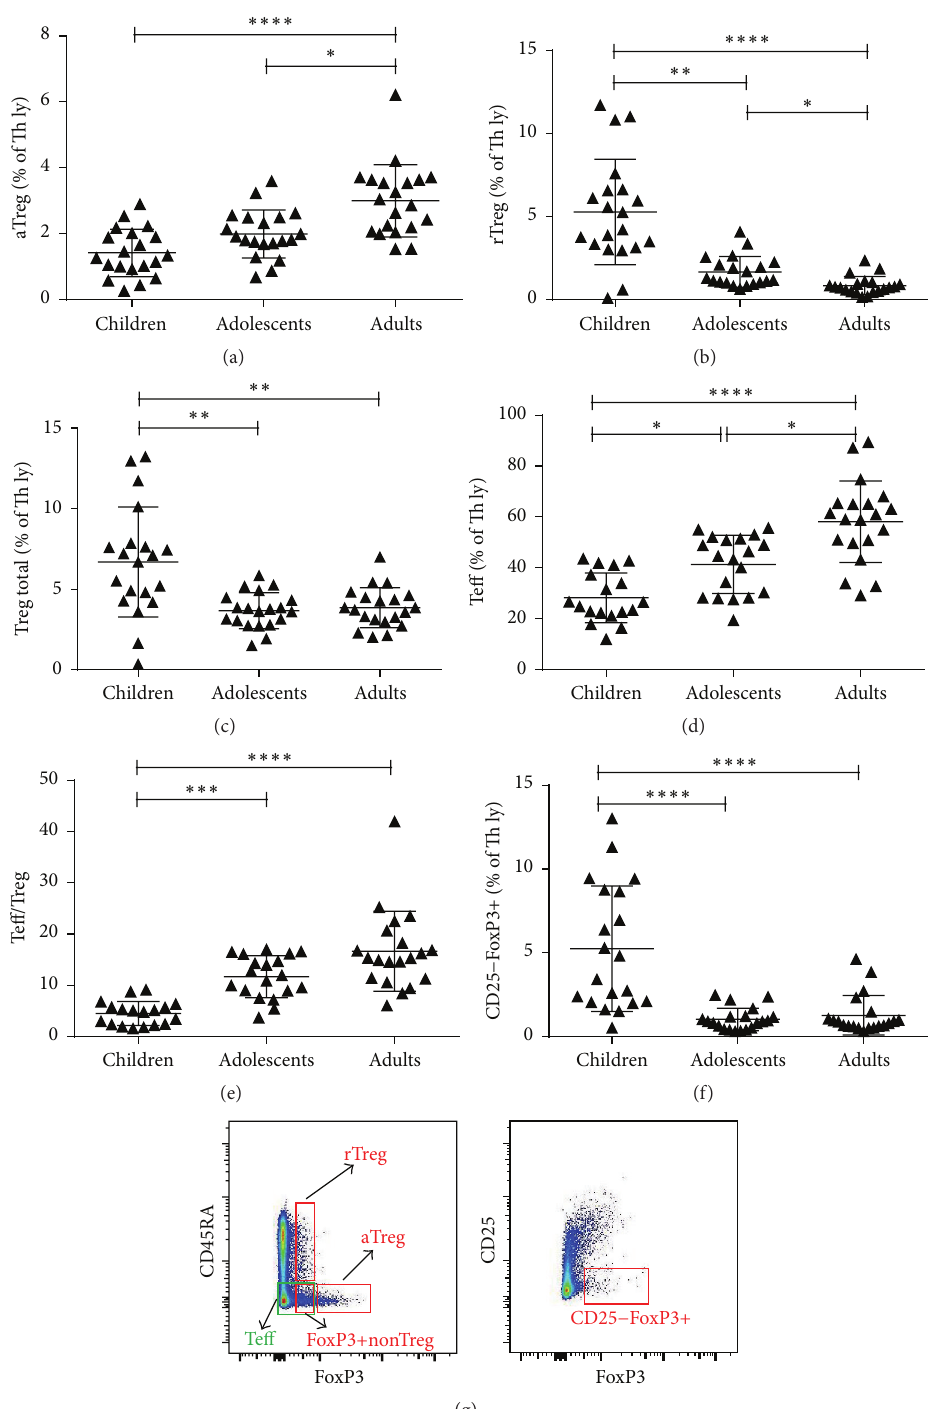
Figure 2: Treg lymphocyte subset difference among populations. (a) The percentage of aTreg lymphocytes was higher in adults compared to children as well as adolescents. (b) The percentage of rTreg lymphocytes decreased with age. There was a significant difference between all three subject groups. (c) The percentage of total Treg lymphocytes dropped with age as well, but there was no significant difference between the groups of adolescents and adults. (d) The percentage of Teff lymphocytes escalated significantly with age. (e) The ratio between Teff and Treg lymphocytes increased with age with a significant difference between children and adolescents as well as between children and adults. (f) The percentage of CD25 − FoxP3+ Th lymphocytes dropped significantly from childhood to adolescence and stayed low in adults. Each symbol in graphs (a) to (d) represents a single sample. The black lines in graphs (a) to (d) indicate the mean value with standard deviations. ∗ 𝑃 < 0.05 ; ∗∗ 𝑃 < 0.01 ; ∗∗∗ 𝑃 < 0.001 ; ∗∗∗∗ 𝑃 < 0.0001 . (g) Gating strategies and staining patterns for identification of subpopulations aTreg, rTreg, FoxP3+nonTreg, Teff, and CD25 −